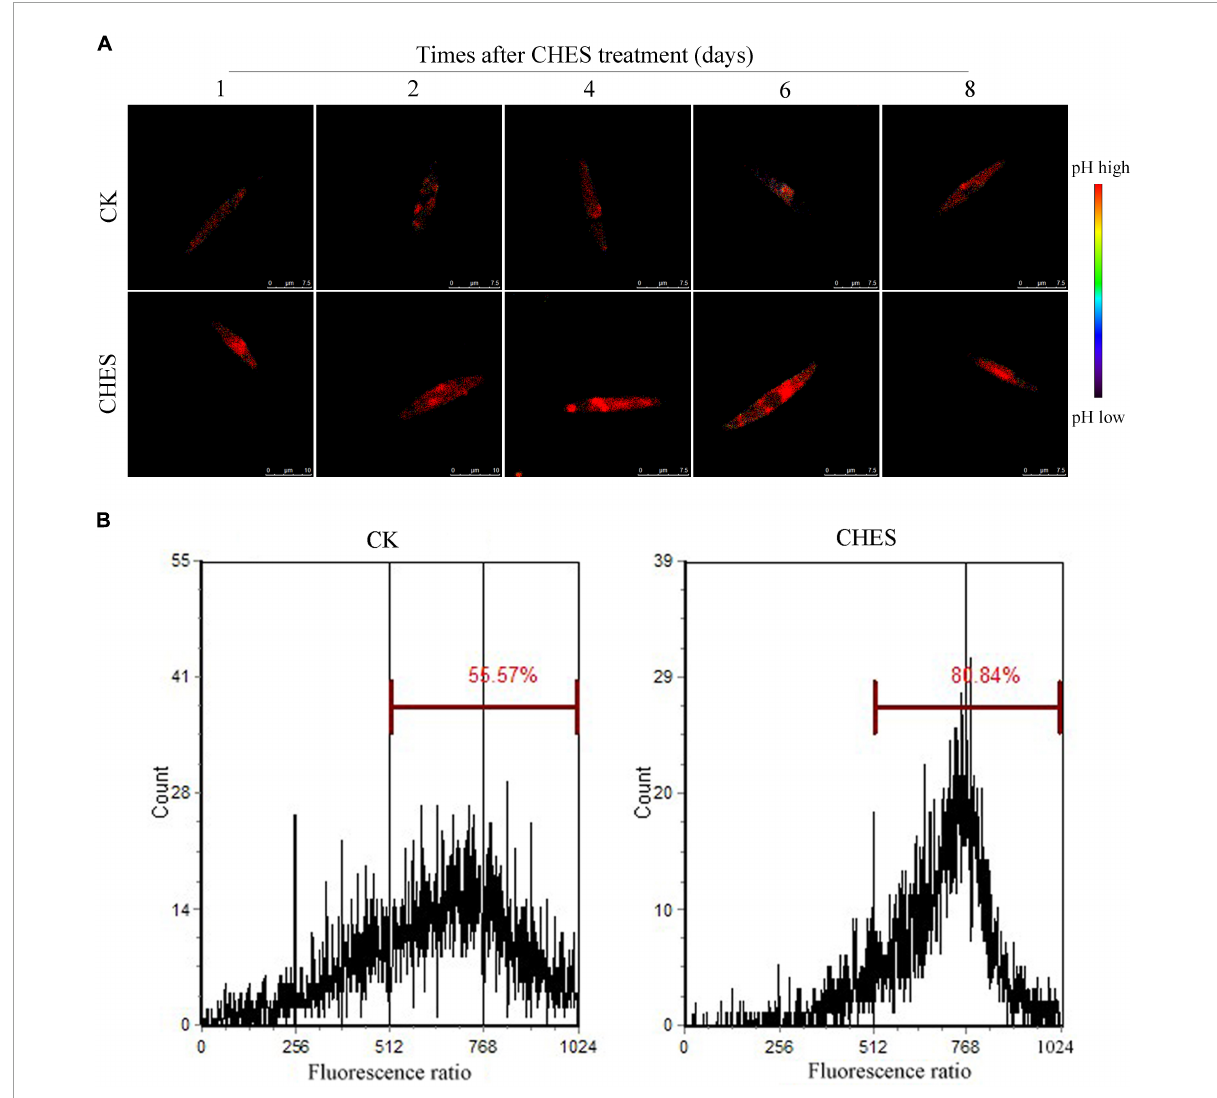
FIGURE3 Change in intracellular pH under CHES treatment in P. tricornutum. (A) P. tricornutum cells were stained with BCECF (Ex: 458/488 nm, Em: 530–550 nm). The ratio of 488 nm-excited images to 458 m-excited images was measured as pH i . Bar was shown in the figure. (B) pHi was determined after 8 d of culture by flow cytometer. BCECF was excited at 488 nm, and the emitted fluorescence at 640 nm and 525 nm were sampled. The ratio of 525/640 nm fluorescence was calculated as pH i